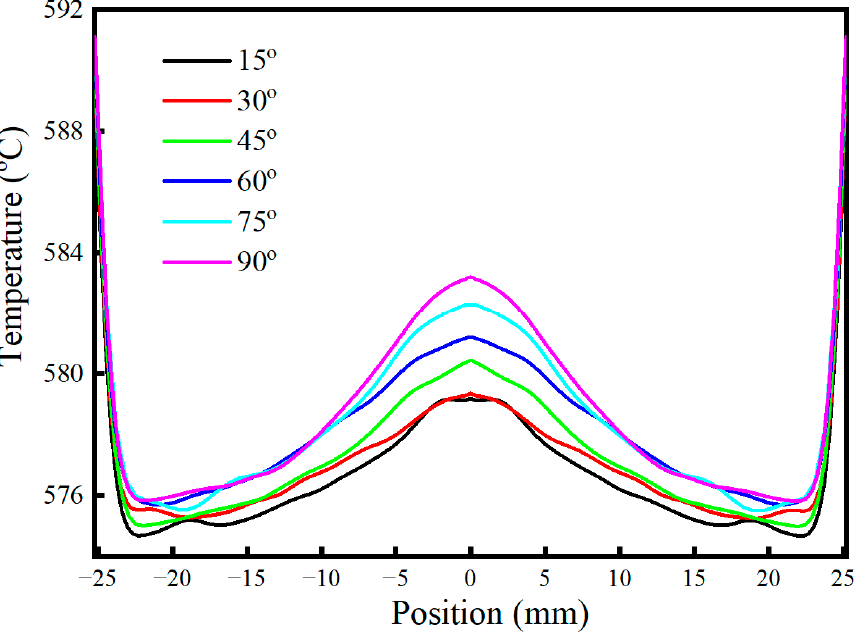
Figure 10. Effect of lower bridge angle on the model-predicted exit temperature across the extrudate at a mid-thickness location (the black line in Figure 8f).